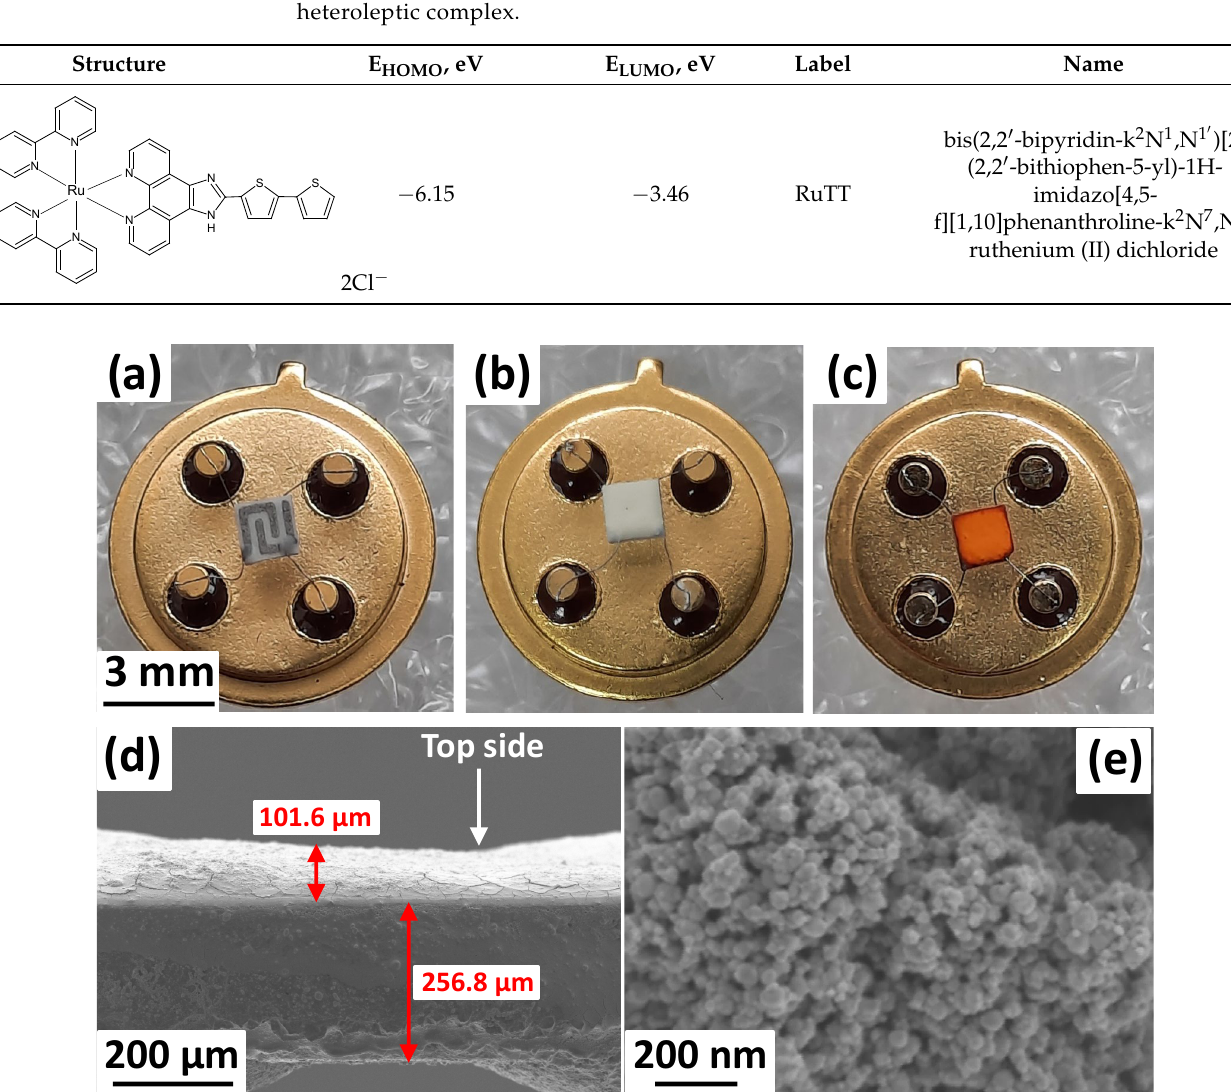
Figure 1. Microelectronic hotplate ( a ) before and ( b ) after deposition of a thick semiconductor film on the substrate and ( c ) after sensitization with a Ru(II) heteroleptic complex; SEM images of the sensitive layer deposited on the substrate, ( d) side view and ( e ) top view.